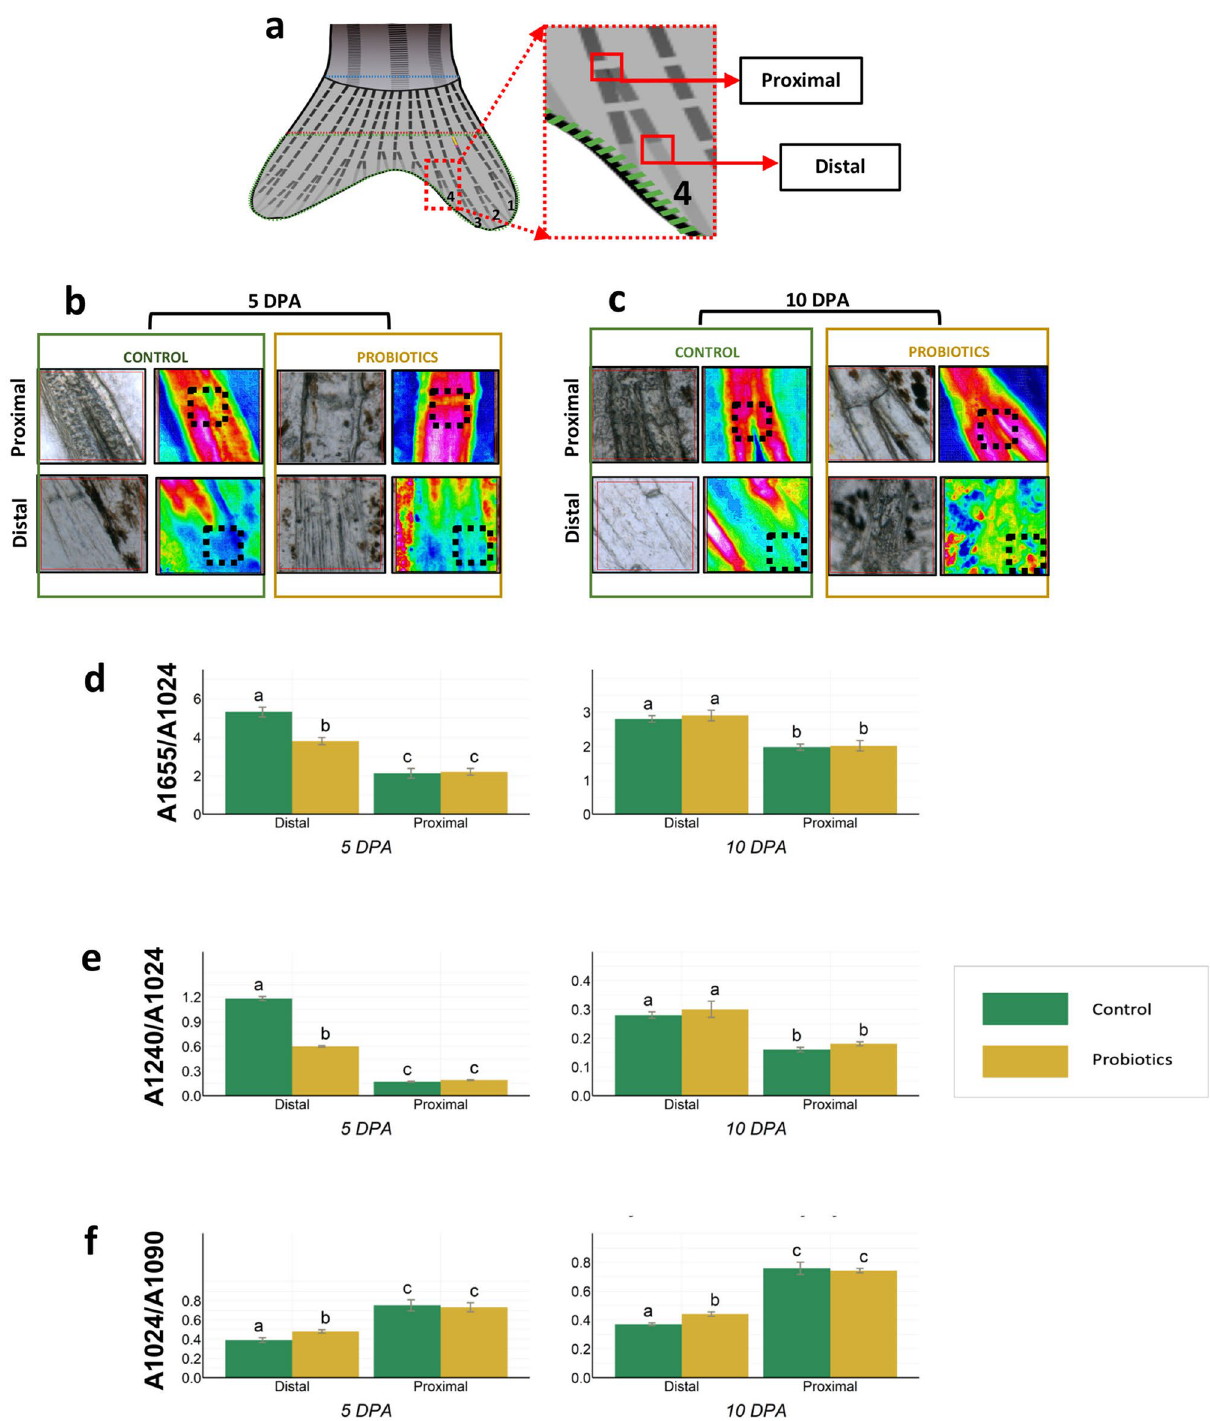
Figure 2. ( a ) Representative picture showing the areas analyzed by FTIRI in the fourth bifurcated fin ray of the dorsal lobe of the regenerating fin. The two regions assayed after amputation were: proximal-corresponding to the first formed bifurcation after amputation and distal-corresponding to the last segment joint preceding the actinotrichia; ( b and c ) Representative microphotograph (left) and false color images (right) denoting the topographical distribution of phosphate groups in the proximal and distal areas of the regenerated fin from C and P fins (n = 3) at ( b ) 5 DPA and ( c ) 10 DPA time points. The same color scale (0–3) was used for all false color images: white/light pink colors indicate the areas with the highest amount of phosphates, red/orange/yellow indicate the areas with an intermediate amount and black/dark blue shows the areas with the lowest amount of phosphates. The black dotted squares indicate the region where spectra were extracted for the curve fitting analysis; ( d – f ) Biochemical composition and bone mineralization assessed by FTIRI analysis. Histograms representing band area ratios ( d ) A 1655 /A 1024 , ( e ) A 1240 /A 1024 and ( f ) A 1024 /A 1090 are calculated on proximal and distal regions of the regenerating fin from C (n = 3) and P (n = 3) fins at 5 DPA and 10 DPA. Data are presented as mean ± S.D. Different letters over the histograms indicate statistically significant difference among groups. Two-way ANOVA and Tukey’s multiple comparison test are used, and statistical significance was set at p <